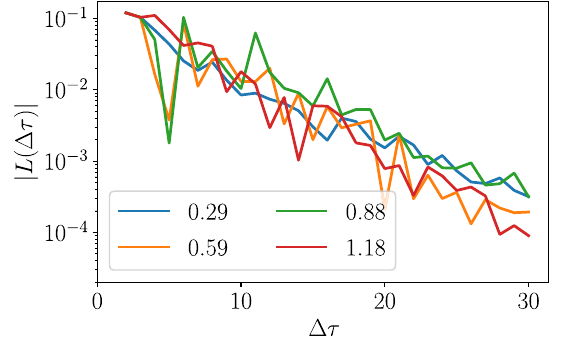
FIG. 7. Absolute value of the Loschmidt echo L ð Δ τ Þ , equiv- alent to a weight of a single blip, plotted as a function of blip duration Δ τ near the PD point δ J ¼ δϵ ¼ 0 . 06 for different values of h reported in the legend. A constant blip that consists of q ↑ spin configurations is considered. The decay is approximately exponential, with a rate that is nearly independent of h , and exhibits pronounced time-dependent fluctuations around an exponential